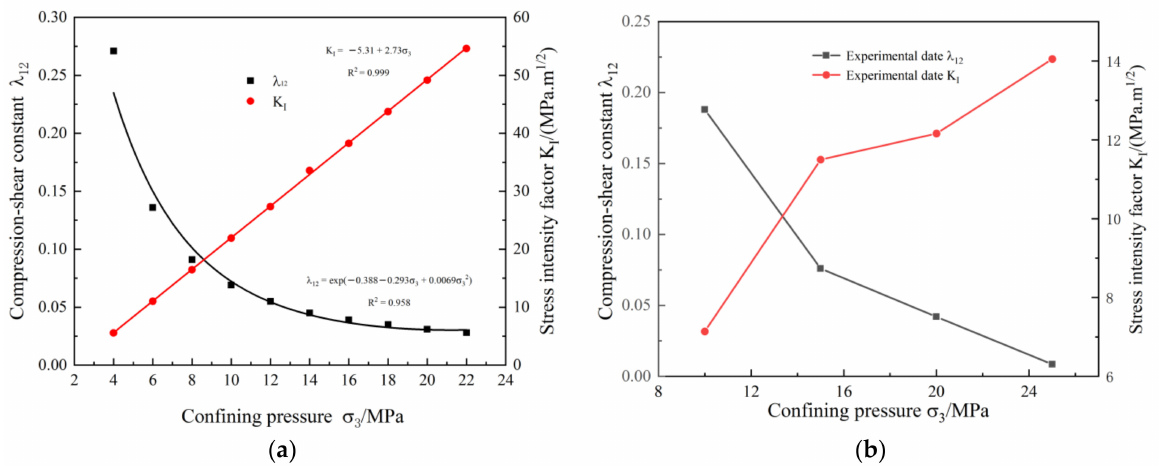
Figure 9. The relationship curves between compression-shear constant, stress intensity factor, and confining pressure. ( a ) Theoretical data; ( b ) experimental data [33].